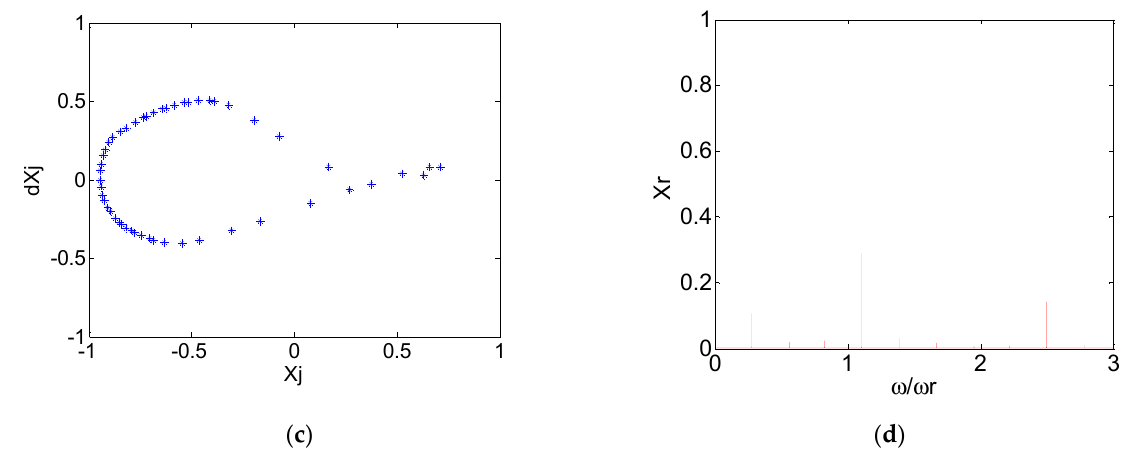
Figure 8. Dynamic response of the floating ring system λ = 0.01 and speed ratio is S = 2.25: ( a ) time-domain waveform; ( b ) orbit; ( c ) Poincare section; ( d ) the FFT spectrum of the disk.